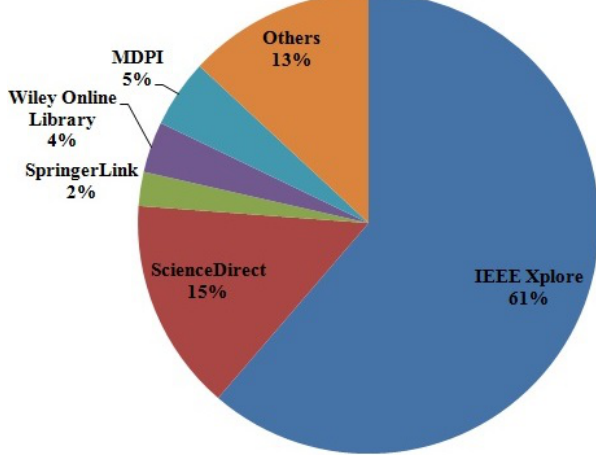
Figure 2. Database-wise review